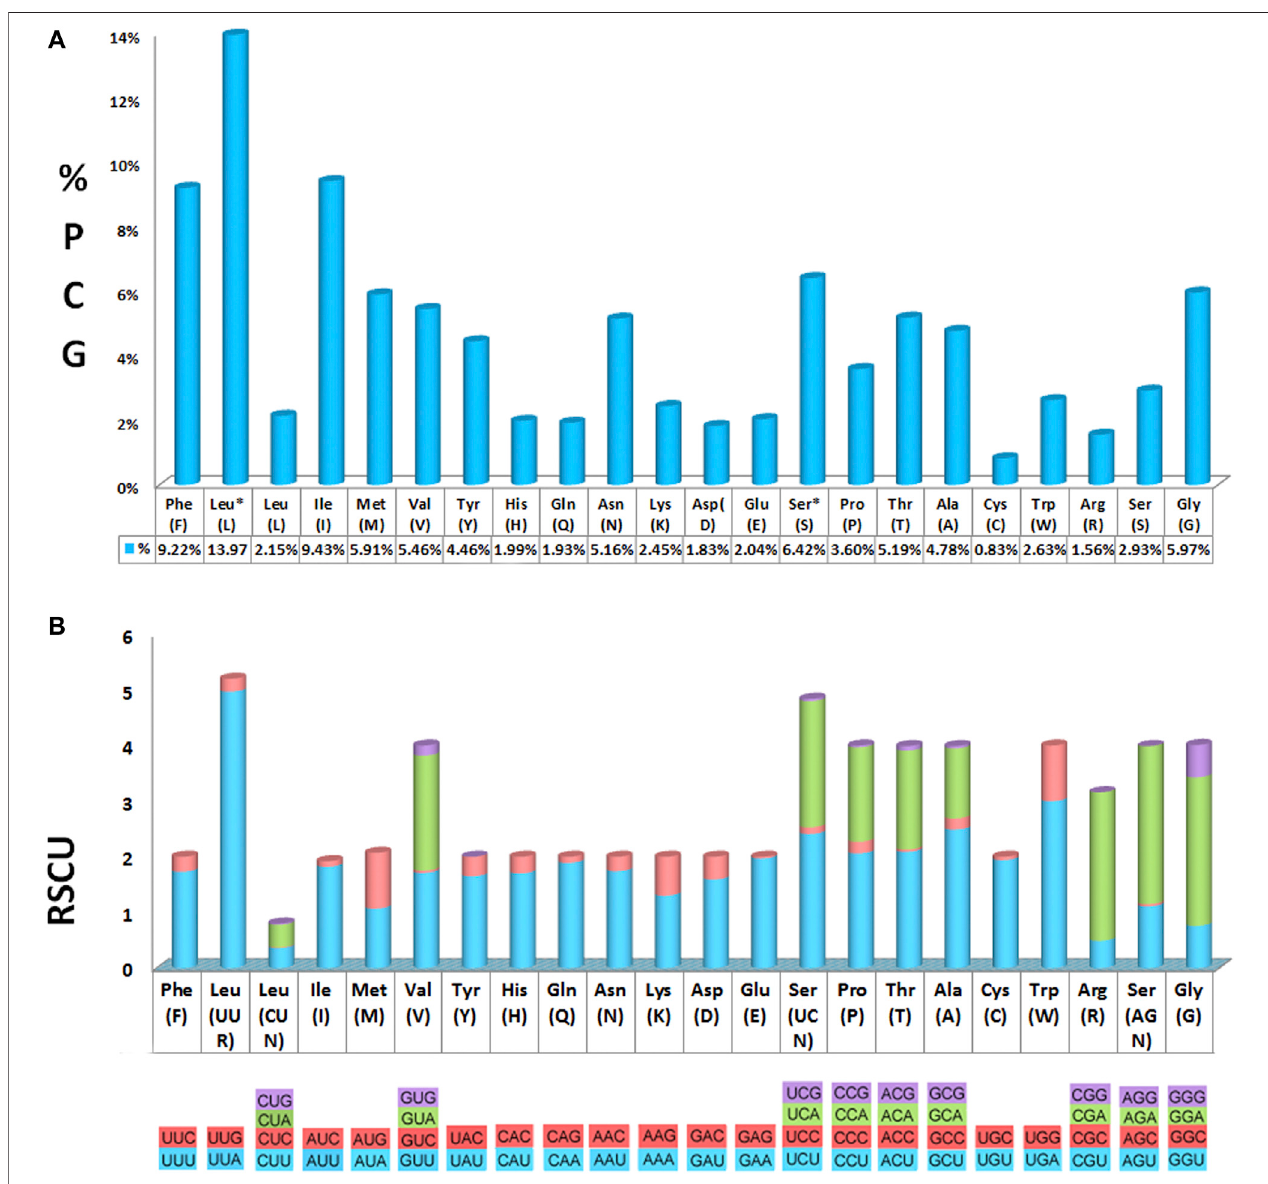
FIGURE 2 | Amino acid distribution and relative synonymous codon usage (RSCU) in the Calliphora nigribarbis mitogenome. (A) Codon distribution. (B) RSCU. Codon families are provided on the X axis and the RSCU on the Y axis. This mitogenome presents all possible codon families existing in Diptera.